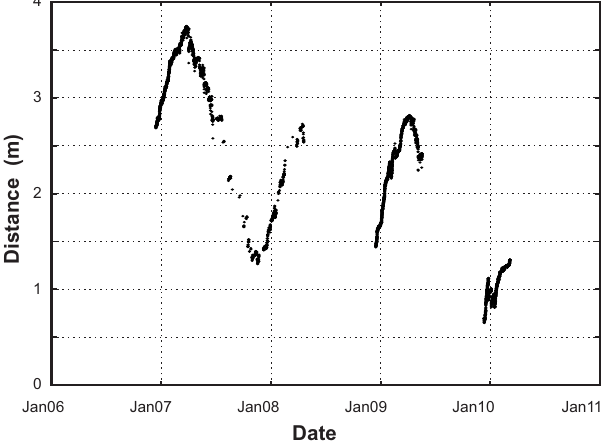
Table 2. Temperature-radiation index model